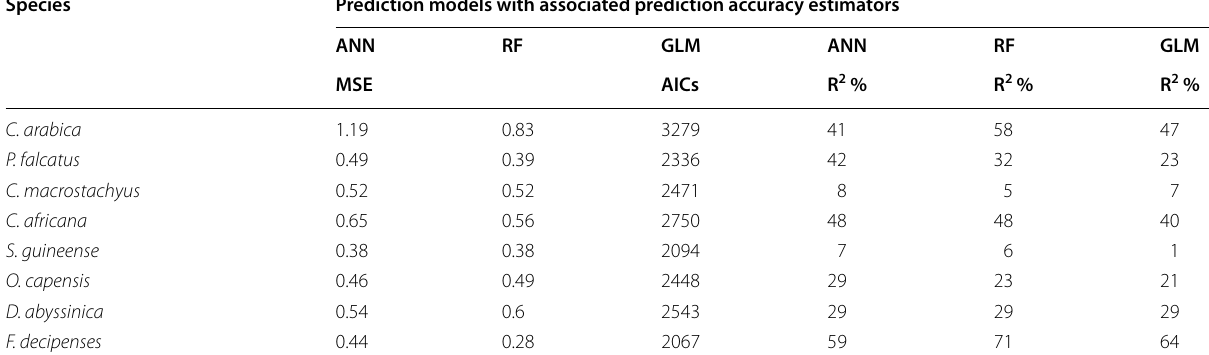
Species Prediction models with associated prediction accuracy estimators